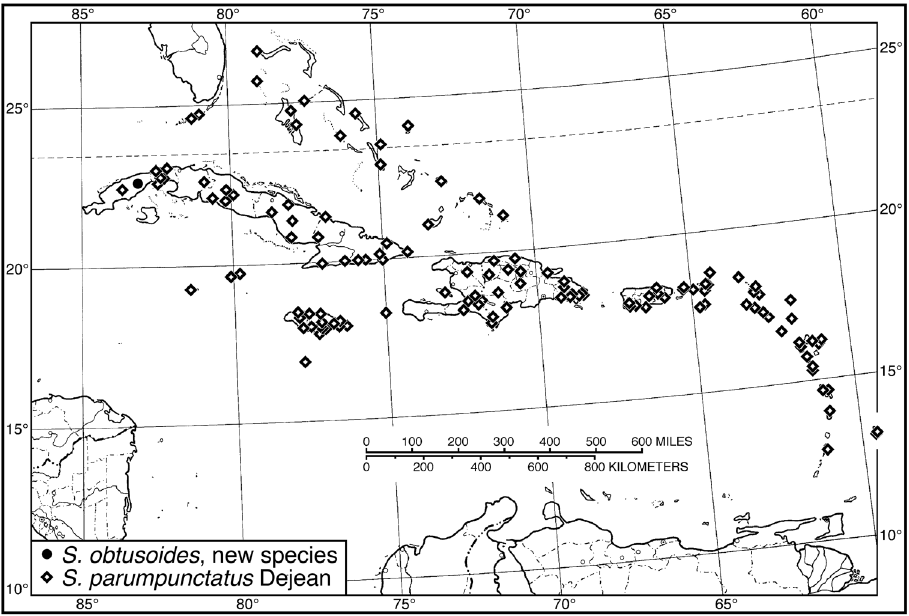
Figure 57. Map of West Indies showing known localities for species of Selenophorus parumpunctatus species